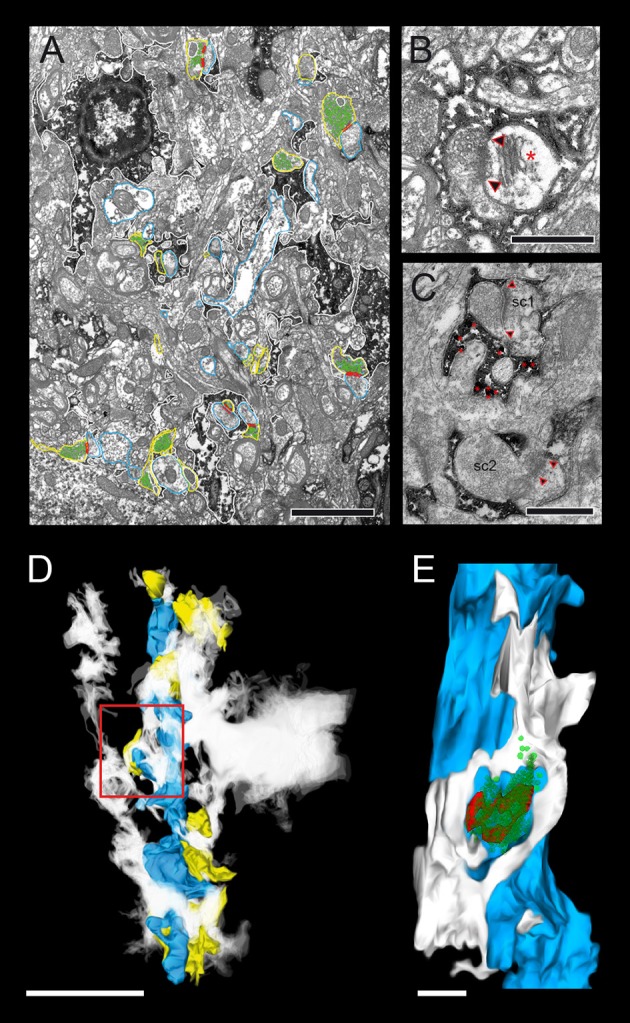
Astrocytic coverage of L5B excitatory synaptic boutons. (A) Low power electron micrograph showing the distribution of astrocytic processes (dark DAB-reaction product outlined in white) comprising a dense network in L5B. Here, all reconstructed synaptic boutons are outlined in yellow, dendritic segments in blue, AZs in red, synaptic vesicles in green. Scale bar in (A) 1 μm. (B) A synaptic complex composed by an en passant synaptic bouton on a dendritic spine is completely ensheathed by fine astrocytic processes (dark DAB-reaction product). The AZ is indicated by the arrowheads, a spine apparatus by an asterisk. (C) Here, immunohistochemistry against GABA was carried out identified as large silver-intensified gold grains (for better visualization marked by red asterisks) in astrocytic processes around sc1, whereas those around sc2 were immune-negative for GABA. Scale bars in (B,C) 0.5 μm. (D) 3D-volume reconstruction of a basal dendritic segment (blue) and several synaptic boutons (yellow) surrounded by a dense network of astrocytic processes given as a white cloud. Scale bar: 0.5 μm. (E) Enlargement of the framed area in (D) showing an individual PreAZ (red) with its pool of synaptic vesicles (green dots) tightly ensheathed by fine astrocytic processes (white) that could be followed to reach the PreAZ. Scale bar in (E) 0.25 μm.